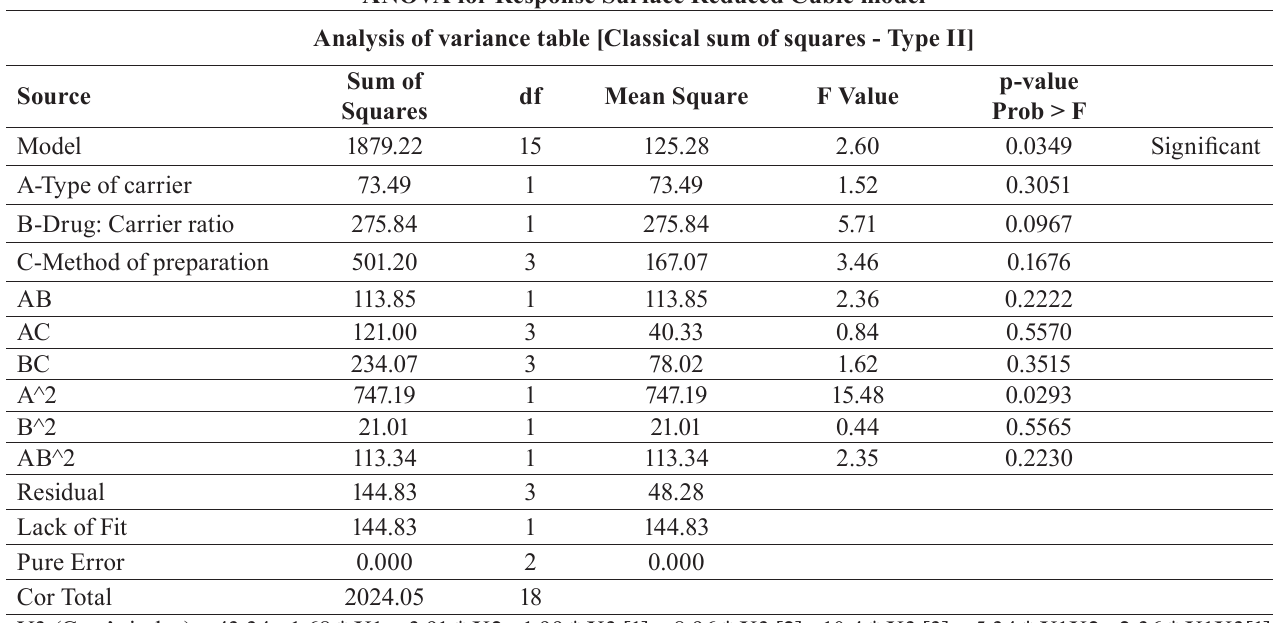
TABLE S3 - ANOVA table for the response variable Carr’s index along with the polynomial equation ANOVA for Response Surface Reduced Cubic model Analysis of variance table [Classical sum of squares - Type II]